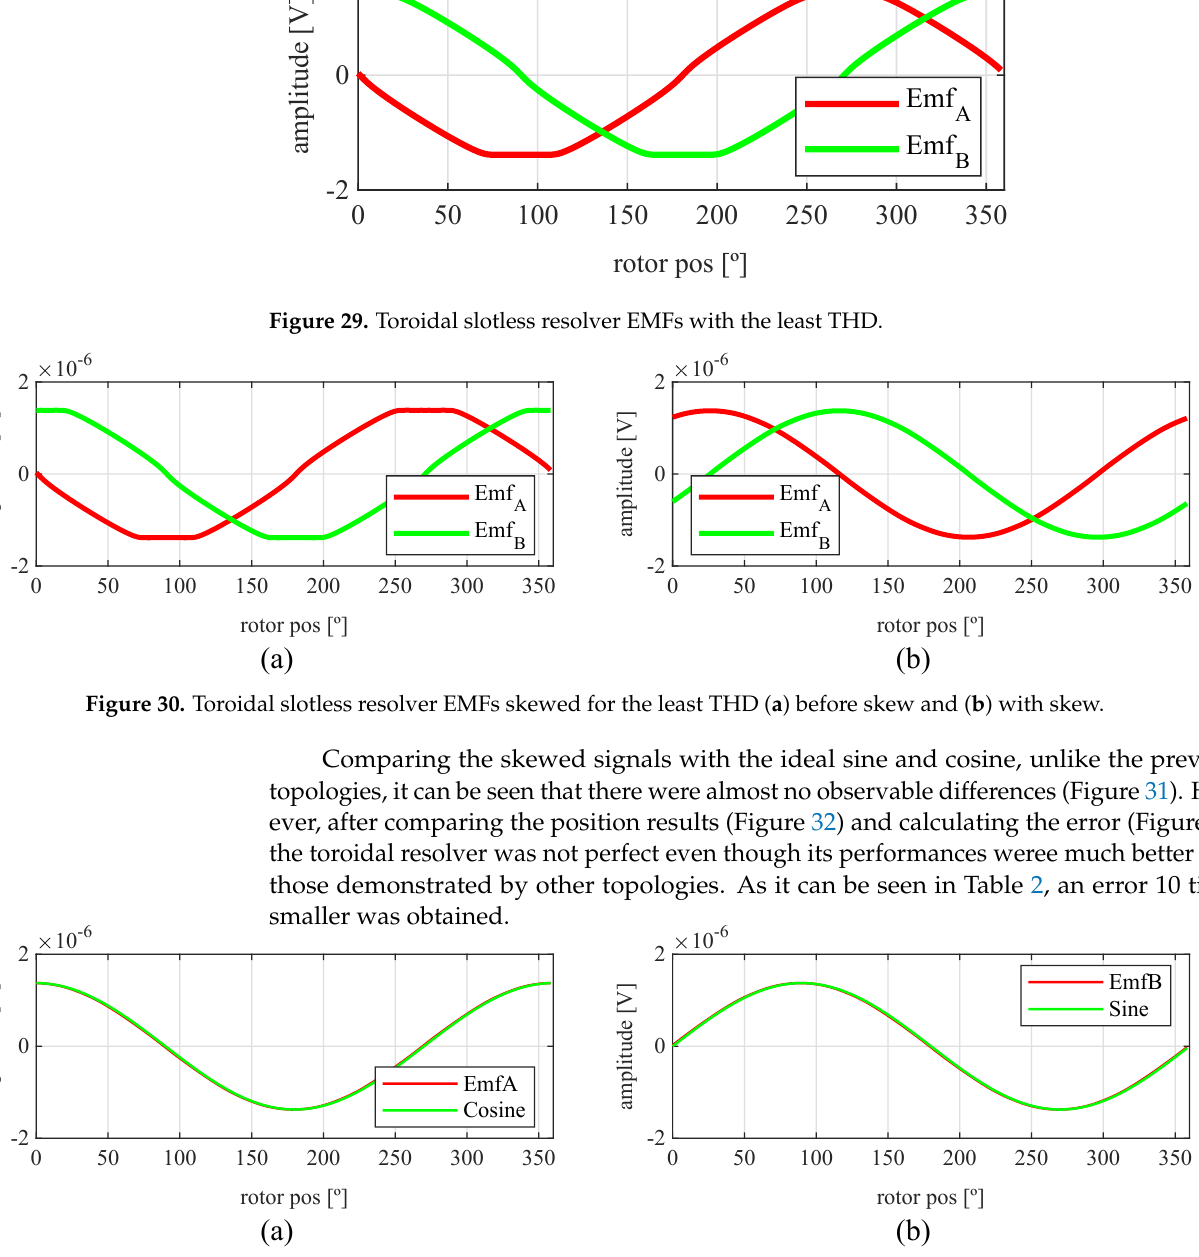
Figure 31. Toroidal slotless skewed resolver EMFs vs. ideal signals ( a ) EMF A vs. Cosine and ( b ) EMF B vs.